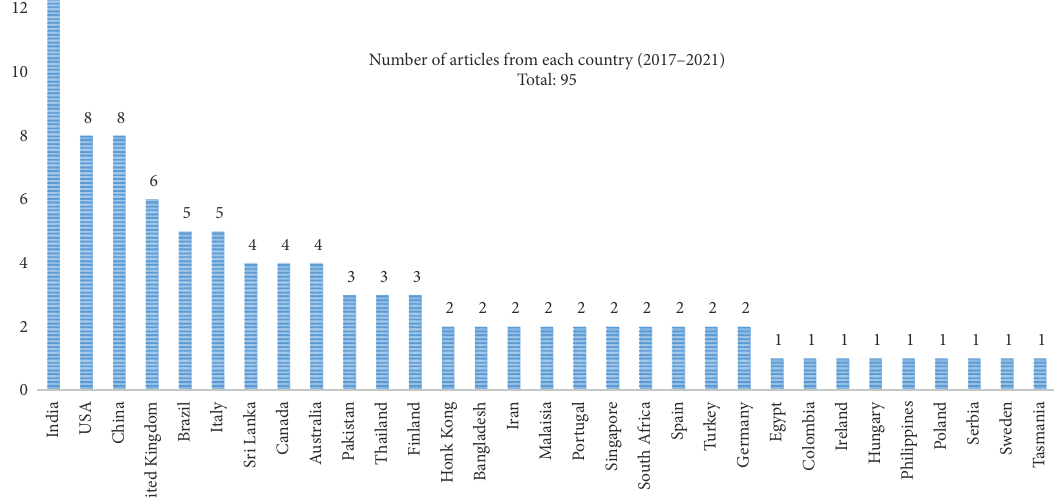
Figure 3. Country-wise distribution of research of SSCM in